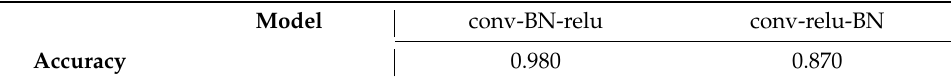
Table 3. Experimental results of two